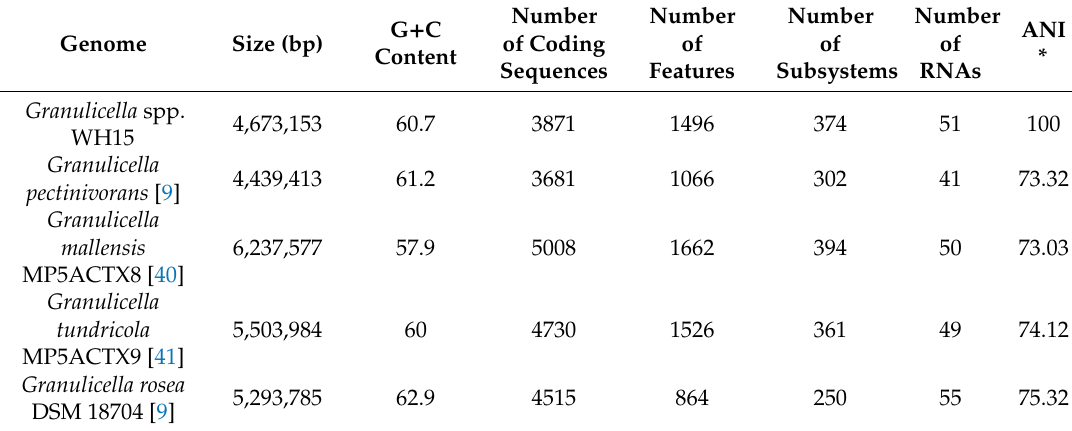
Figure 2. Graphical circular genome map of Granulicella sp. WH15. The rings indicate coding sequences, COG categories, GC content, and GC skew. Table 2. Quantitative comparison of coding sequences, RNA and subsystems among species of Granulicella.